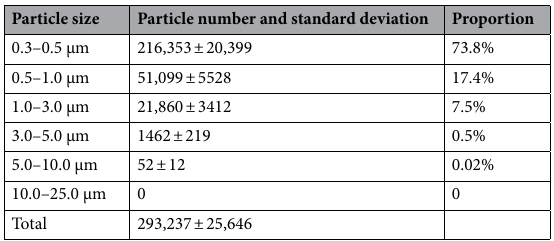
Table 1. Total and size-resolved particle numbers emitted from a flush of the squat toilet.